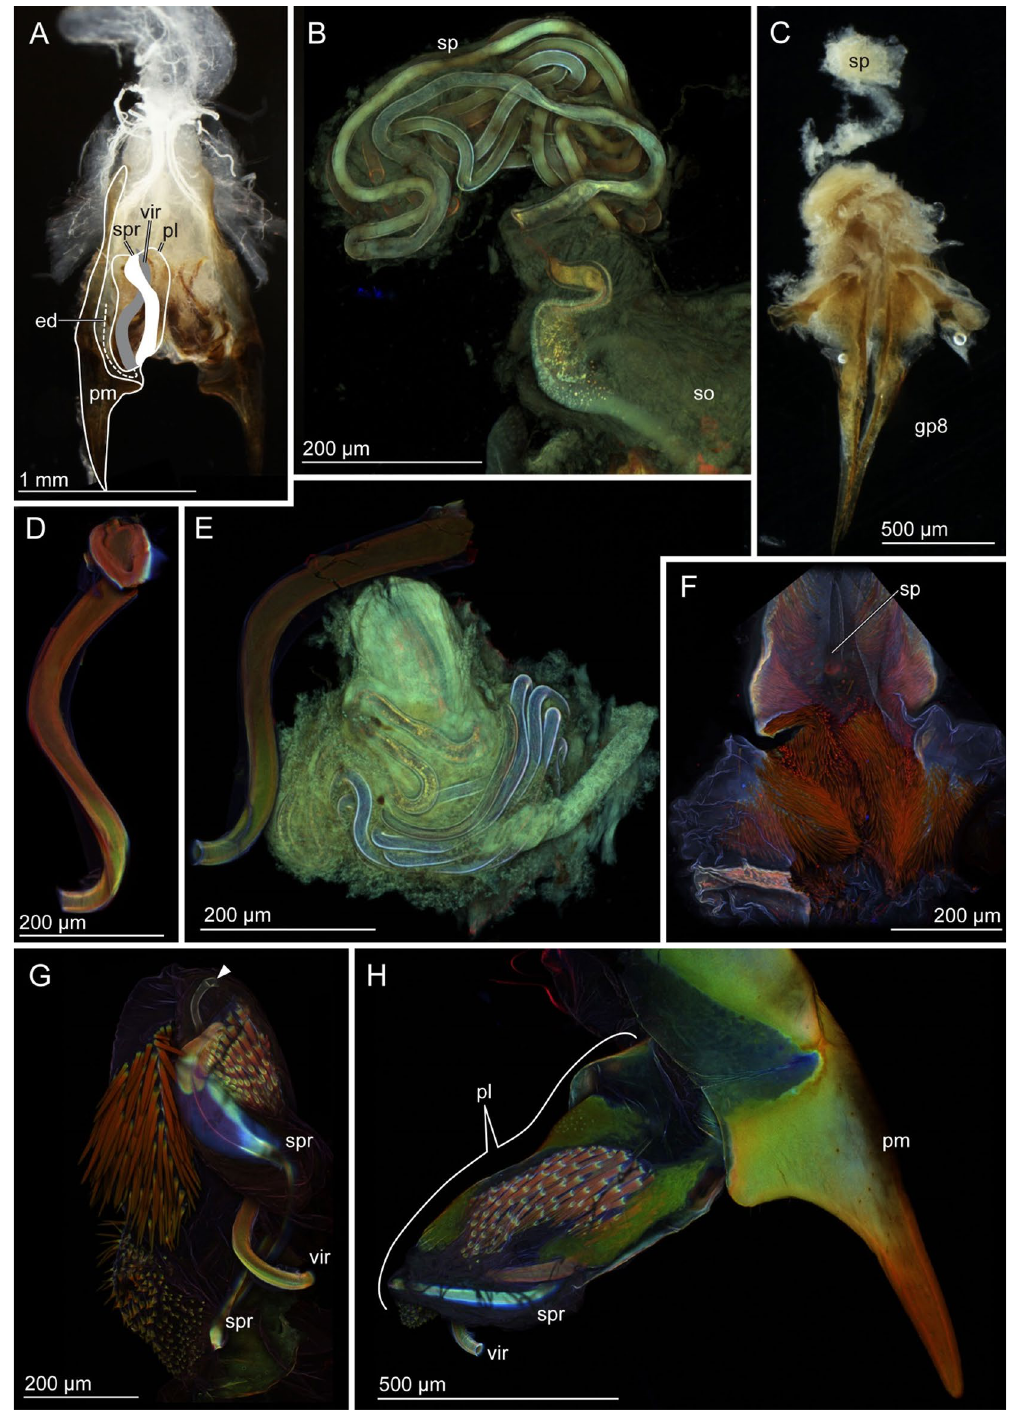
Figure 3. Male and female genitalia of Echinosoma denticulatum. ( A , C ) Stereomicrographs, ( B , D – H ) confocal laser scanning micrographs. ( A ) Male genitalia. Paired penises are situated in the genitalia chamber and direct cranially in repose as seen here. Half of the paired structures is highlighted. ( B ) Spermatheca. ( C ) Female genitalia. ( D ) Virga. ( E ) Virga and spermatheca. ( F ) Numerous setae surrounding a spermatheca opening. ( G ) Virga and its surrounding penis lobe carrying a resilin-enriched spring and numerous spines. The arrowhead denotes the opening of the ejaculatory duct. ( H ) Paramere, virga and penis lobe. Abbreviations: ed, ejaculatory duct; gp8, gonapophysis VIII; pl, penis lobe; so, spermatheca opening; sp, spermatheca; spr, spring; vir,